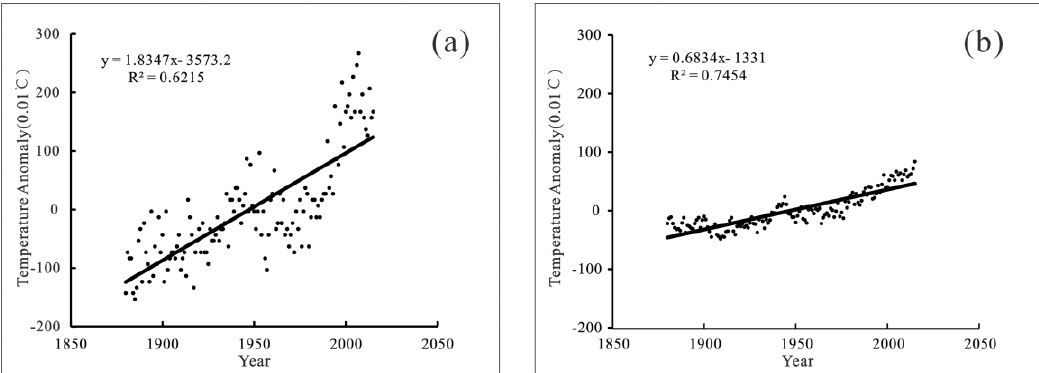
Figure 2. Comparison of the annual temperature anomaly in Shanghai and globally: ( a ) Shanghai temperature anomaly; and ( b ) global temperature anomaly.